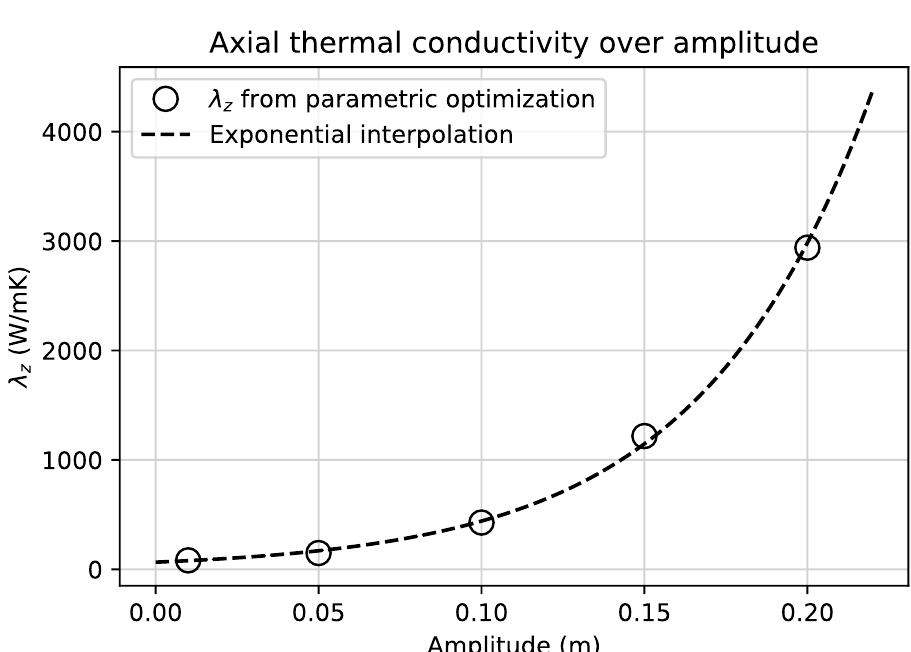
Figure 8. Resulting λ z from the optimization over the amplitude A . Shown also is an exponential trend line.